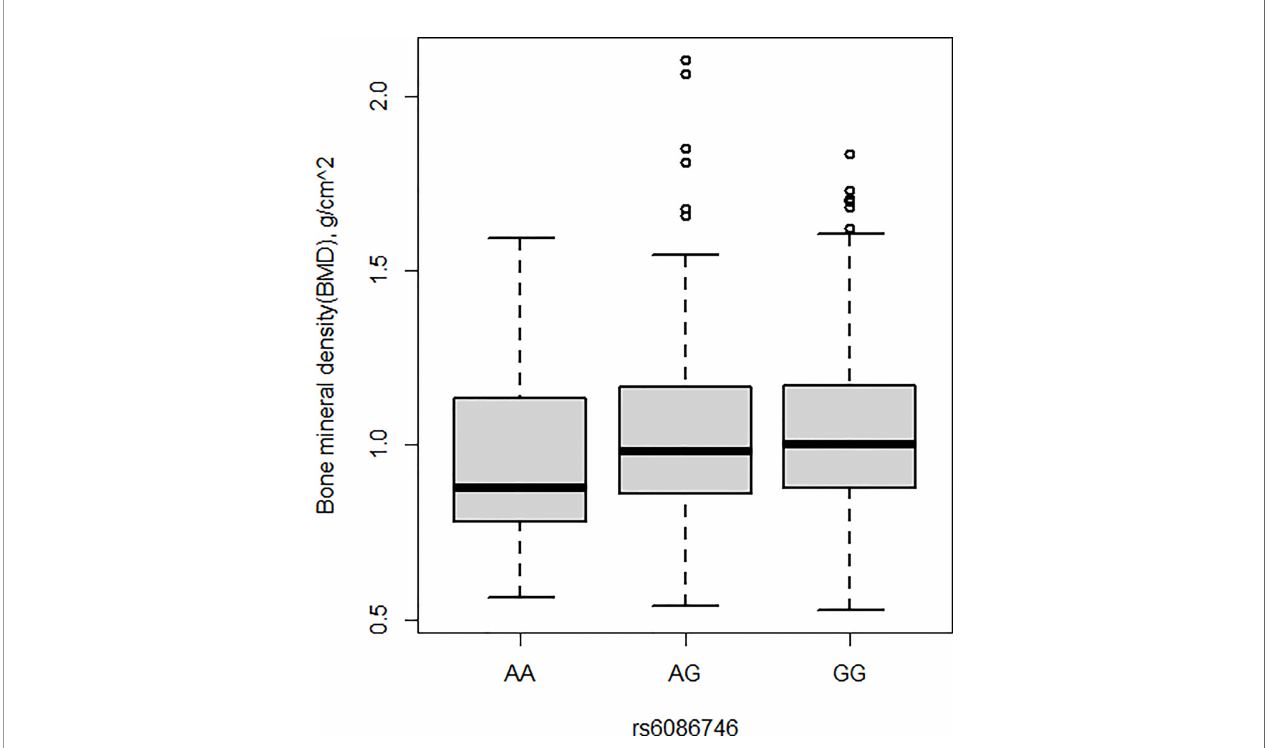
FIGURE 2 | Association of bone mineral density and rs6086746 GG (n = 366), GA (n = 240), AA (n = 39). rs6086746 was determined by G or A in the position of -6363 relative to the PLCB4 gene. Numbers represent the population who has the speci fi ed genotype. BMD, expressed as an areal density in grams per square centimeter, was measured in the lumbar spine (L1 – L4).